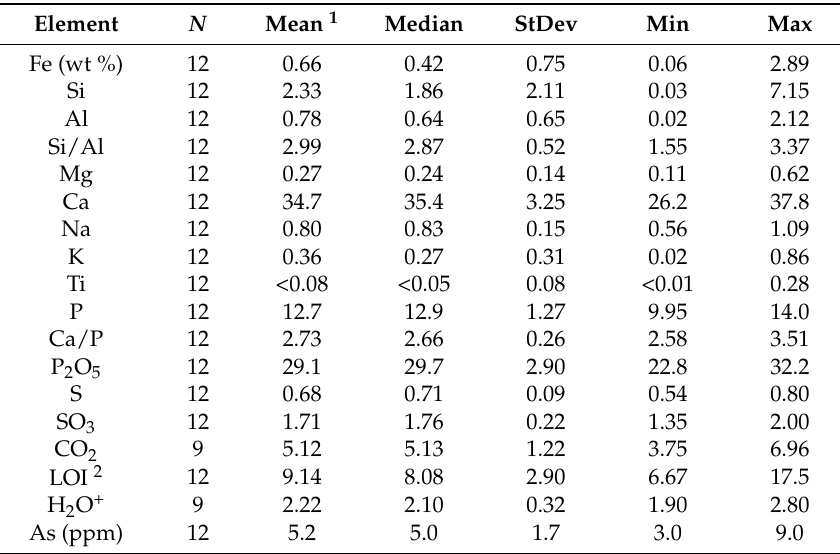
Table 7. Statistics of unleached phosphorite deposits from